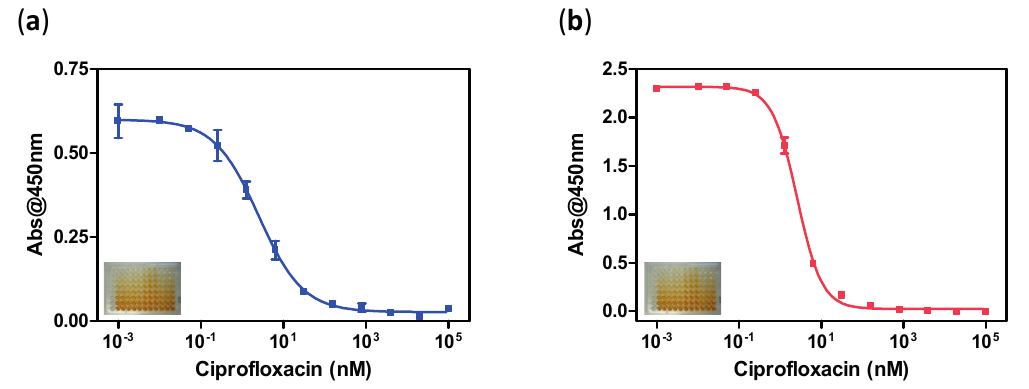
Figure 2. ELISA calibration curves of the different ELISA formats using the immunoreagents produced ( a ) CA in blue; ( b ) TE in red. Each point was the average of at f f least three-well replicates, and the assays were run on two different